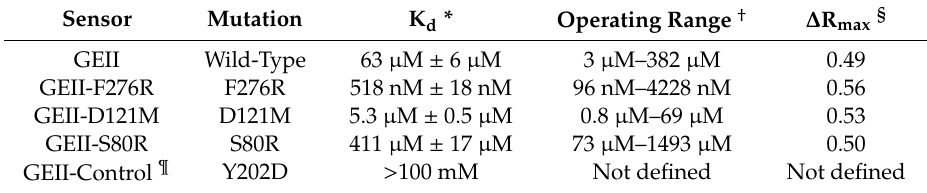
Table 1. In vitro characterization of GEII and its a ffi nity